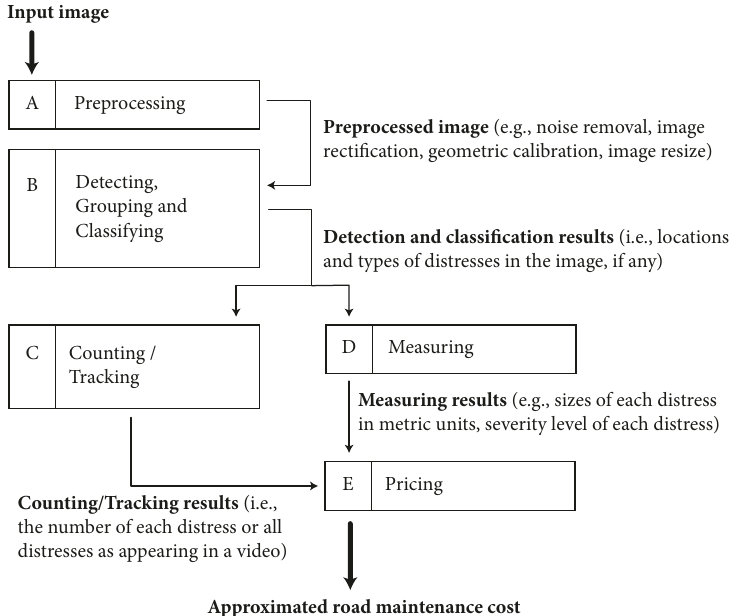
Figure 2: Overall workflow diagram . The brief overview of a vision-based automatic road distress analysis system, including everything from detecting, classifying, measuring, and